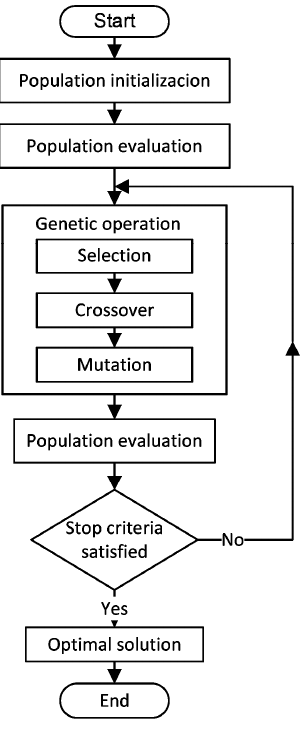
Figure 6. Flowchart for general GAs.